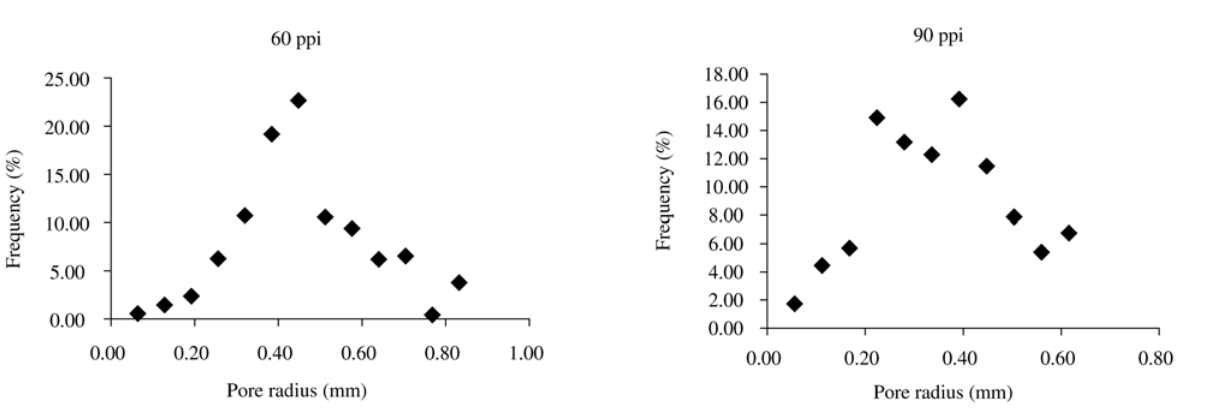
Figure 8. 90 ppi ceramic foam pore size